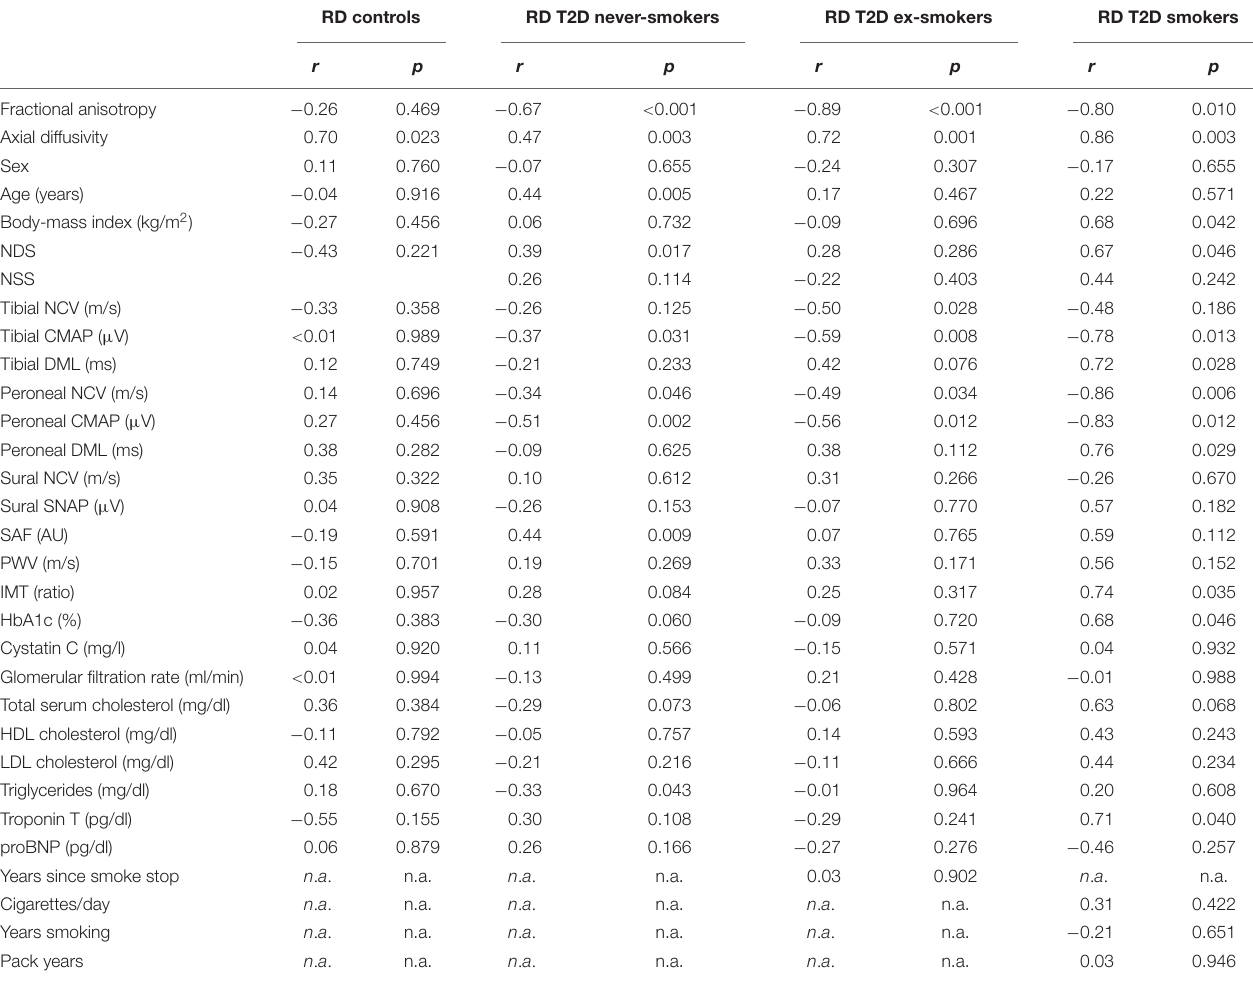
TABLE 3 | Correlation of the sciatic nerve’s radial diffusivity (RD; in 10 − 5 mm 2 /s) with demographic, clinical, apparatus-bound, and serological parameters. RD controls RD T2D never-smokers RD T2D